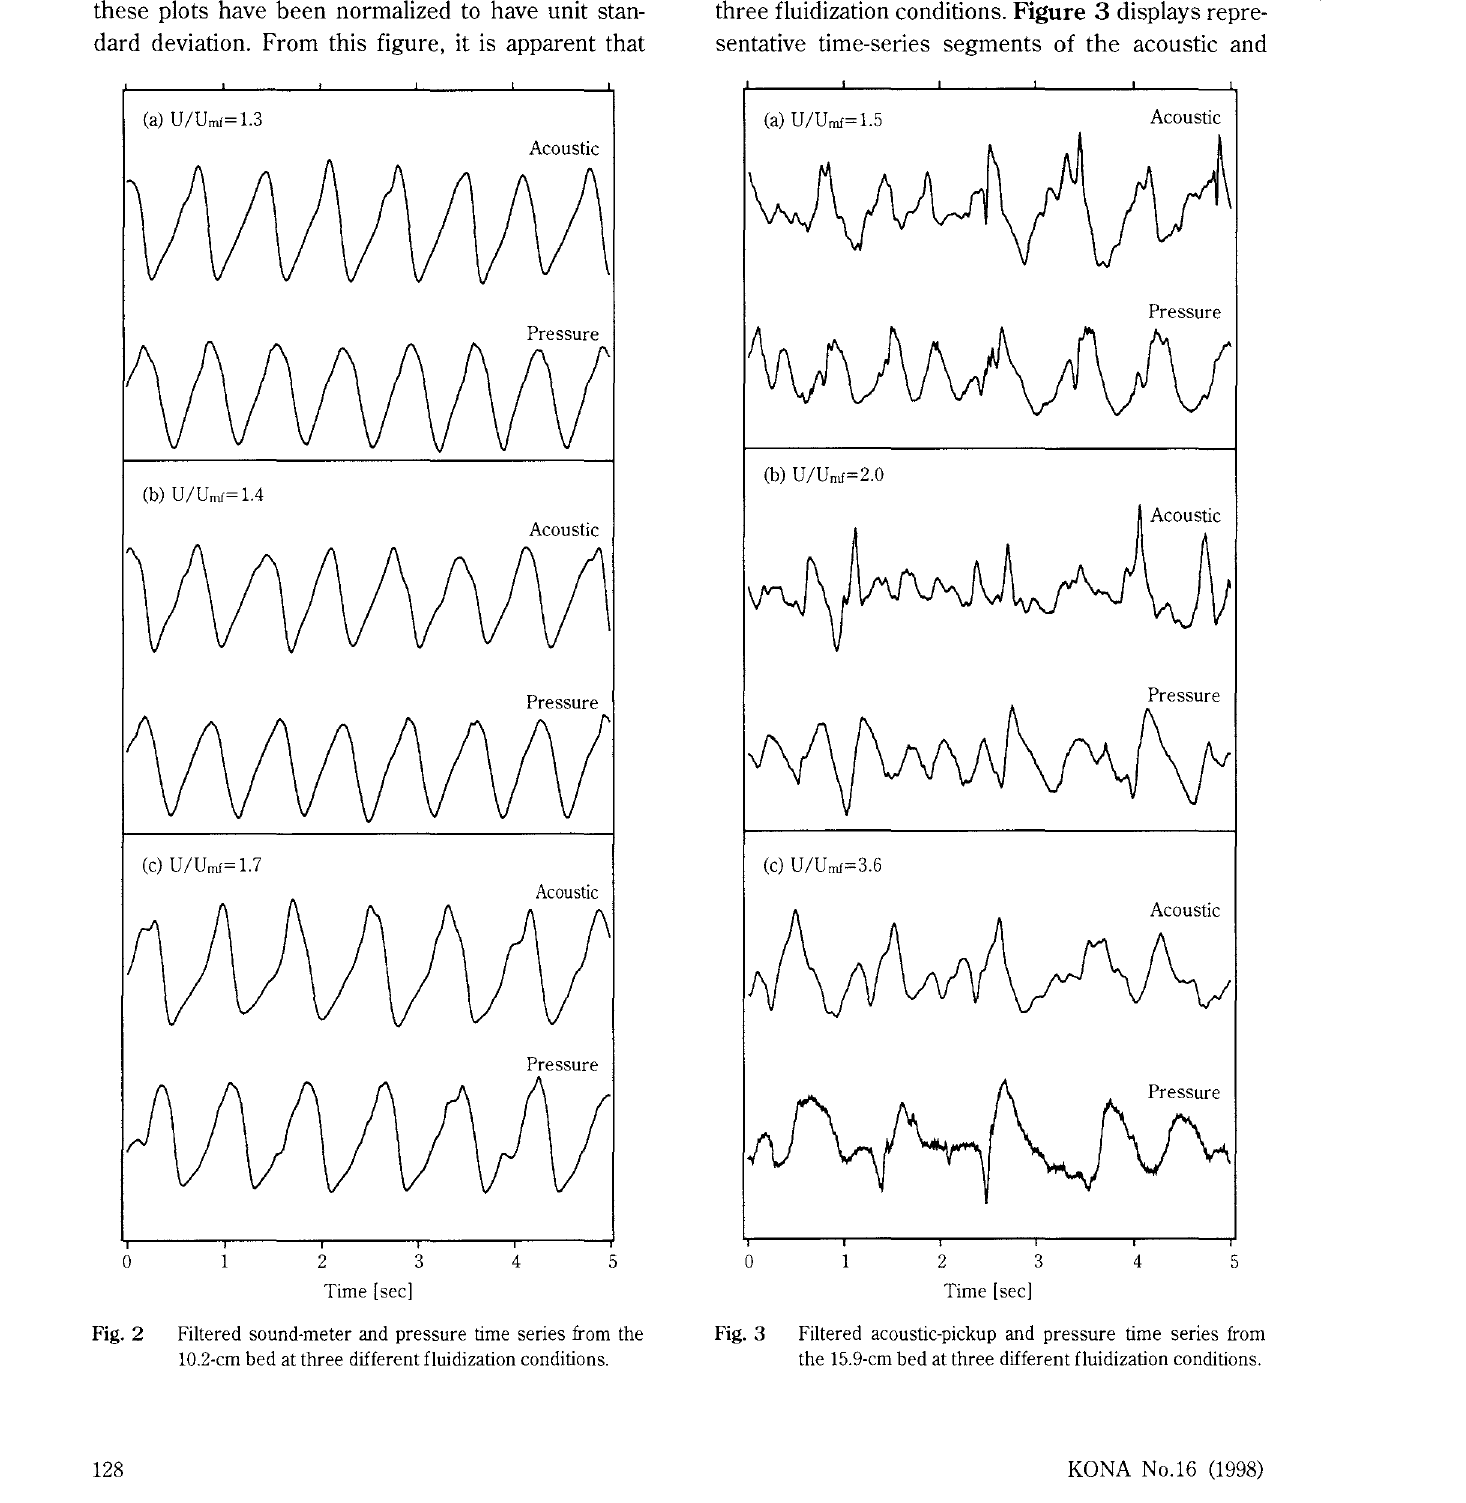
Fig. 2 Filtered sound-meter and pressure time series from the 10.2-cm bed at three different fluidization conditions.